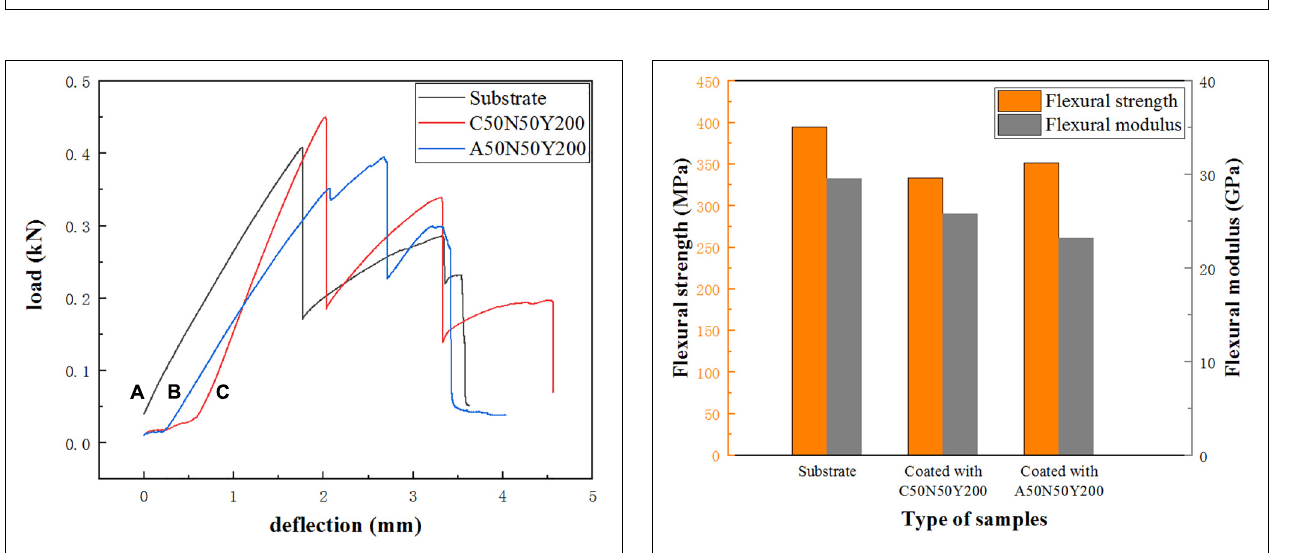
FIGURE 12 | The flexural strength and flexural modulus of different